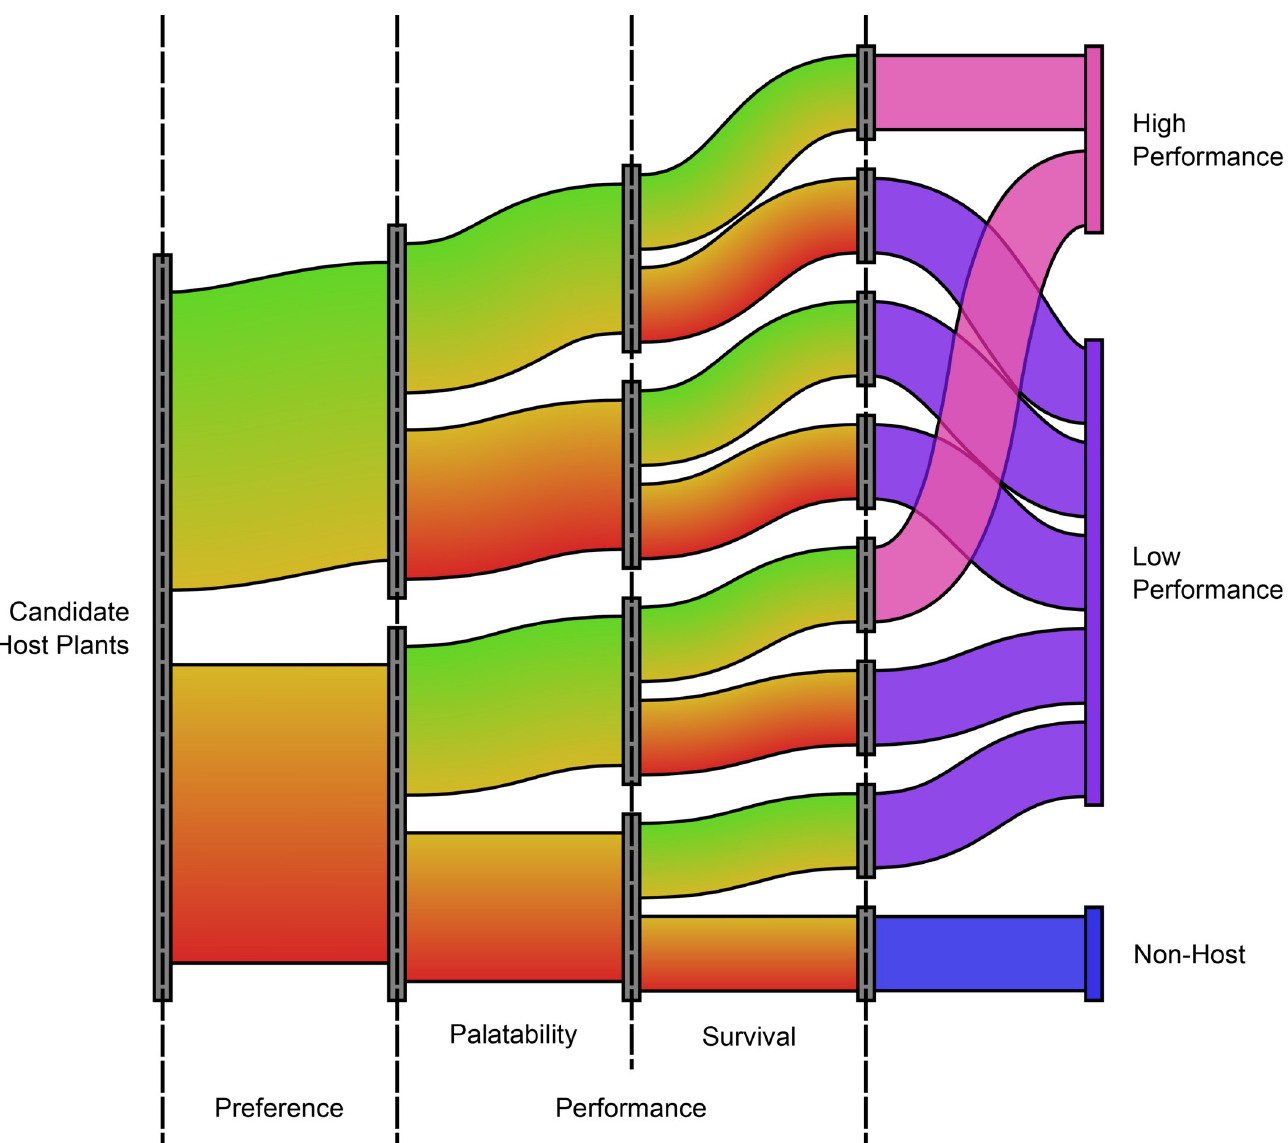
Fig 1. Components and continua of host status. Each of an insect’s potential host plants may land on different parts of preference, palatability, and survival continua, which are not necessarily correlated. A plant’s position along these continua determines its quality as a host.